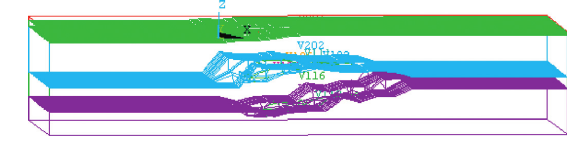
Figure 6: Grid diagram of stratigraphic